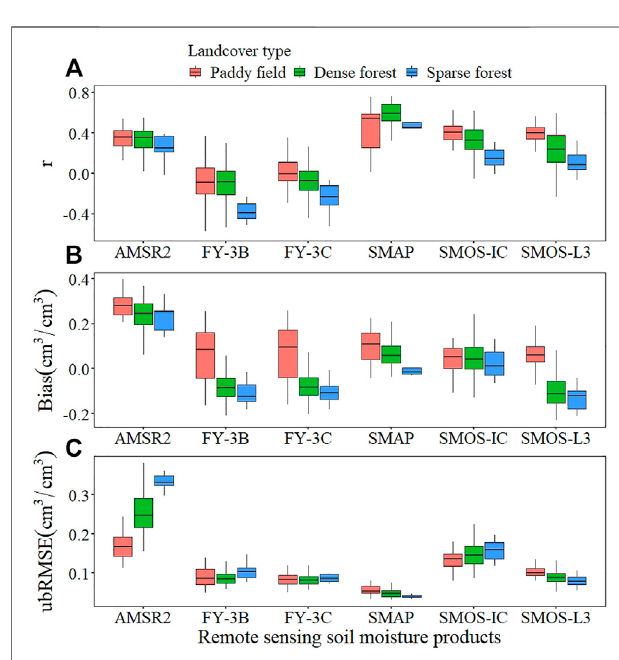
FIGURE5| Boxdiagramsoftypesoflandcoverwitherrorcoef fi cientsof each product.